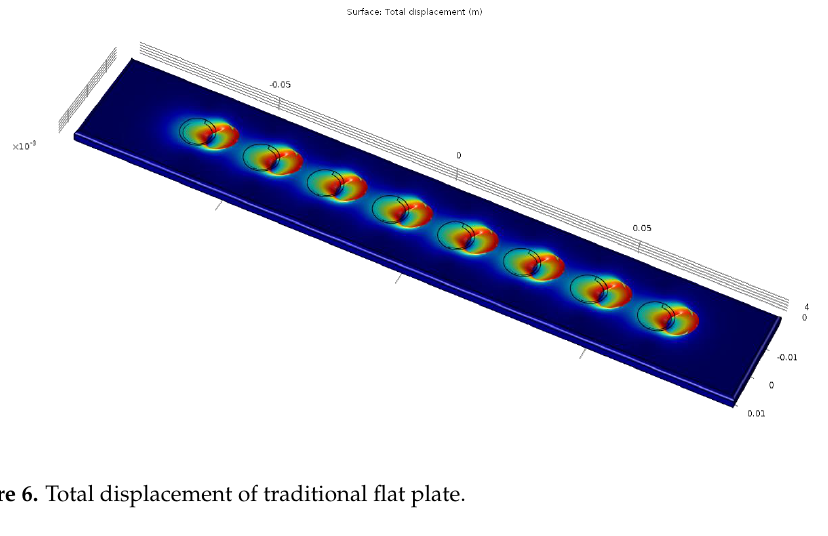
Figure 6. Total displacement of traditional flat plate.